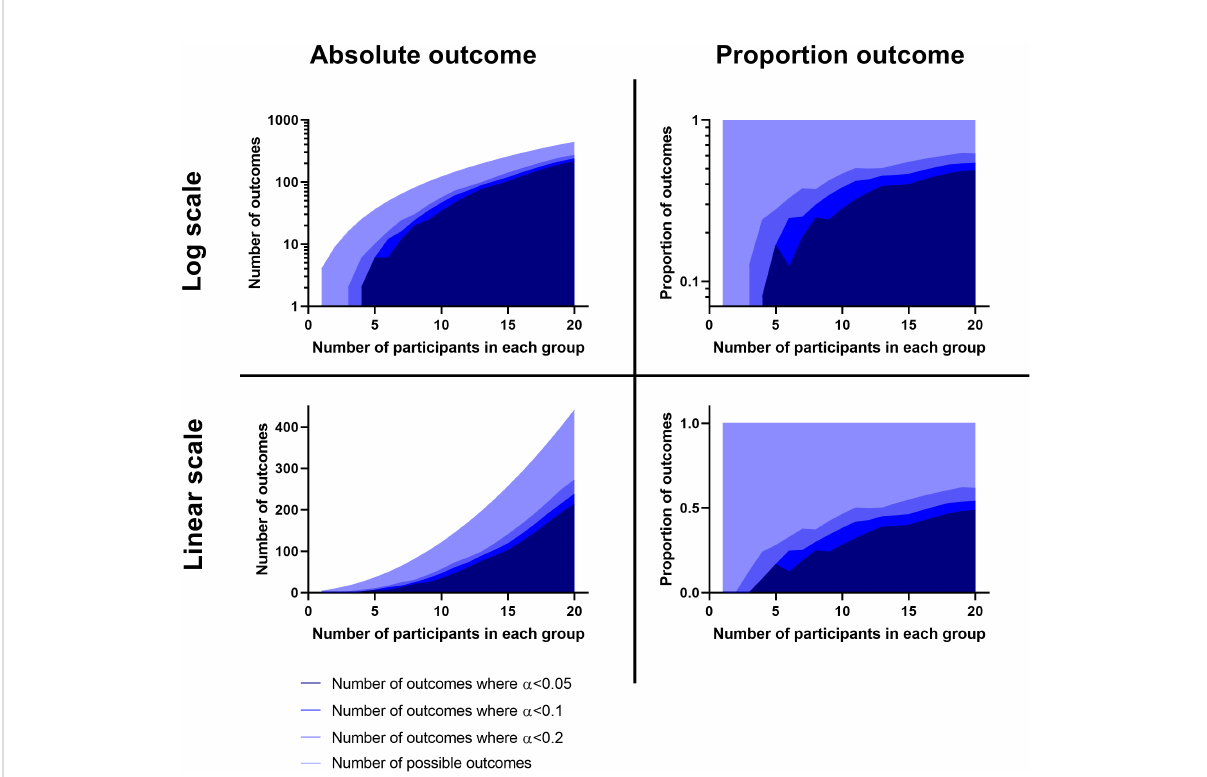
FIGURE 2 Plots showing the number and proportion of outcomes possible using a Fisher ’ s Exact test comparison in relation to how many of these outcomes would be beyond a statistically signi fi cant threshold. Calculations were made using the ‘ fi sher.test ’ function from ‘ stats ’ base package in R V4.1.1 (R Core Team, 2021) and the graphs were prepared using the ‘ xy plot ’ function using single values for y in Graphpad PRISM V8.0 (San Diego). Left are plots of the actual number and right are these as a proportion. Above are these on a logarithmic scale, below are these on a linear